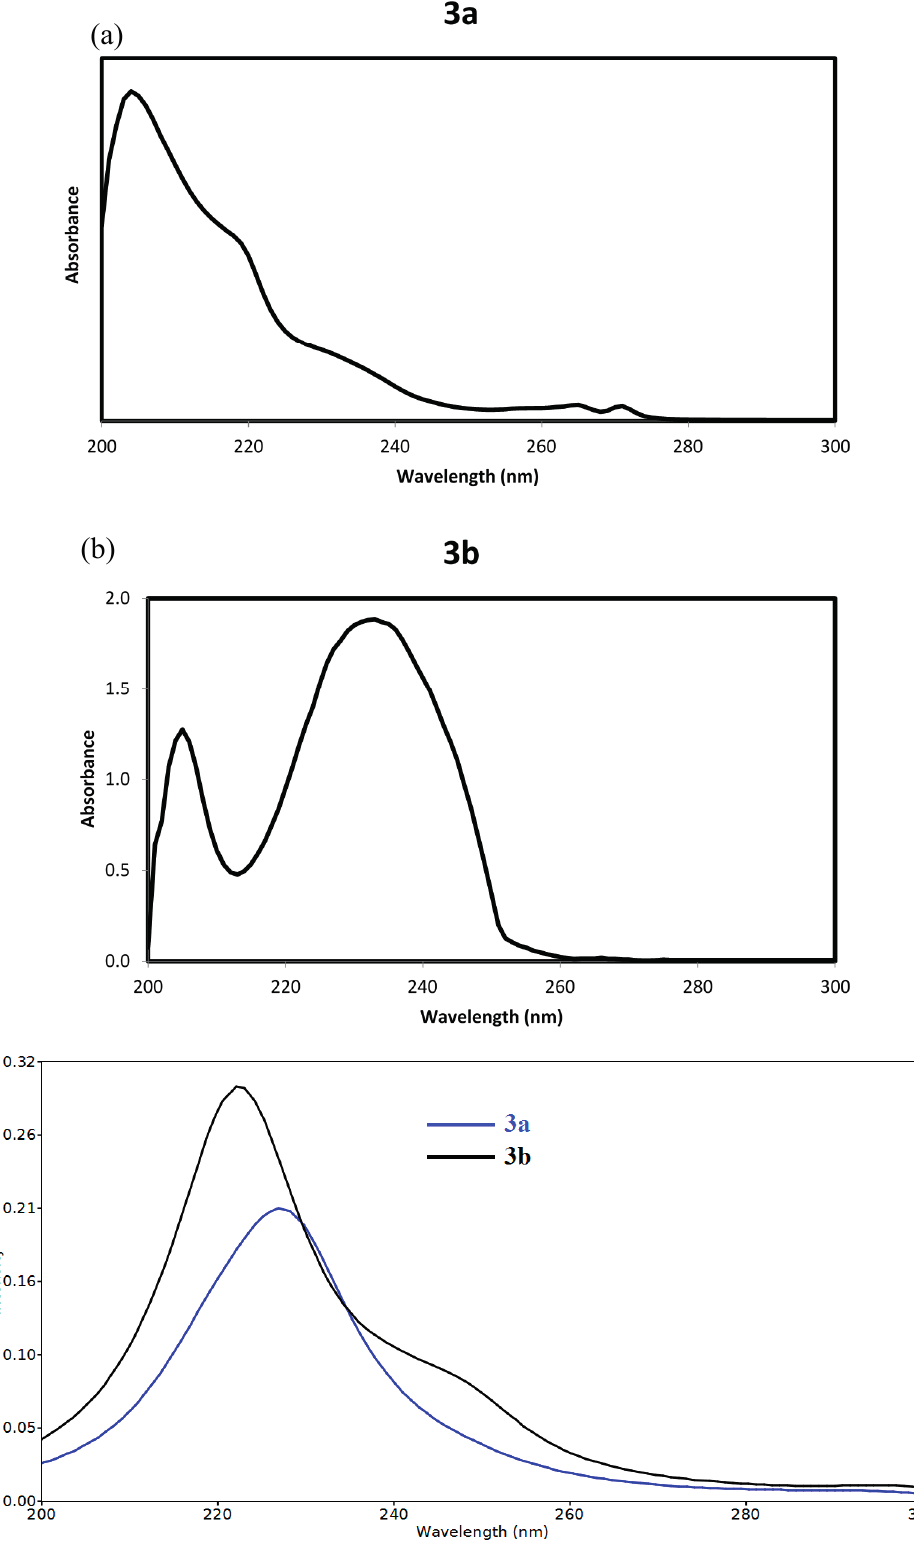
Figure 9. ( a ) The experimental electronic spectra of the studied compounds 3a ; ( b ) The experimental electronic spectra of the studied compounds 3b ; ( c ) The calculated electronic spectra of the studied compounds using TD-DFT